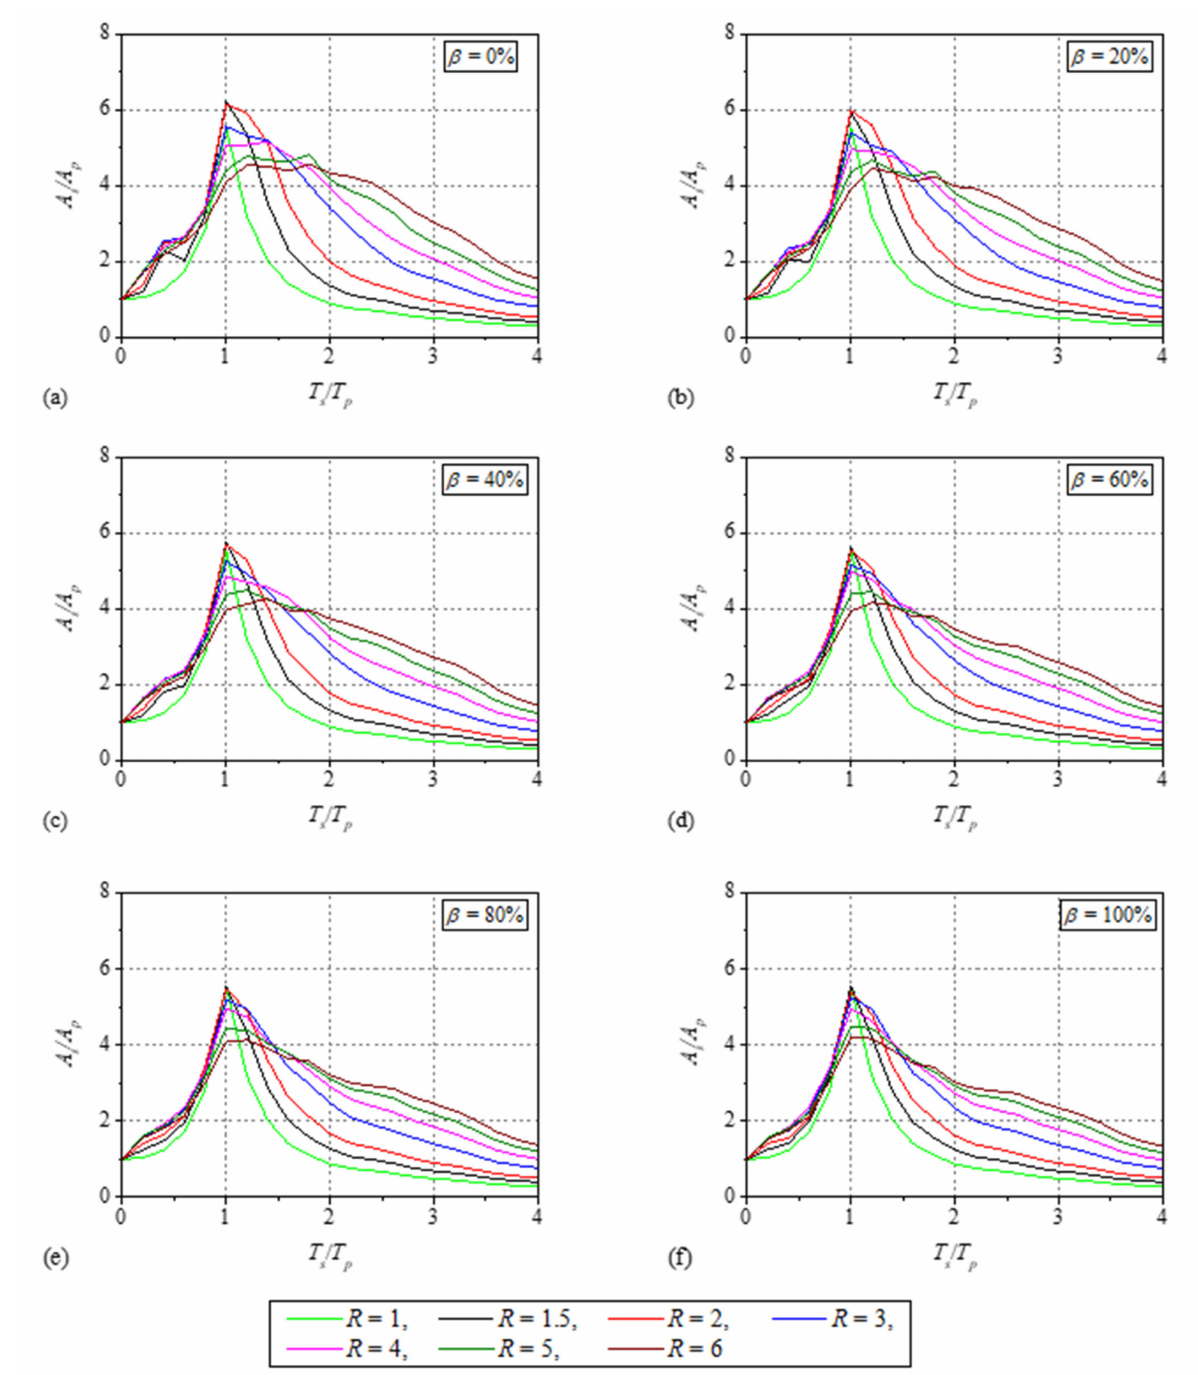
Figure 2. Mean normalized floor response spectra for SC systems with T p = 0.5 s, post-yield stiffness ratio α = 5%; viscous damping ratio ξ p = 5%; and a secondary structure with viscous damping ratio ξ s = 5%: ( a ) β = 0%; ( b ) β = 20%; ( c ) β = 40%; ( d ) β = 60%; ( e ) β = 80%; and ( f ) β =